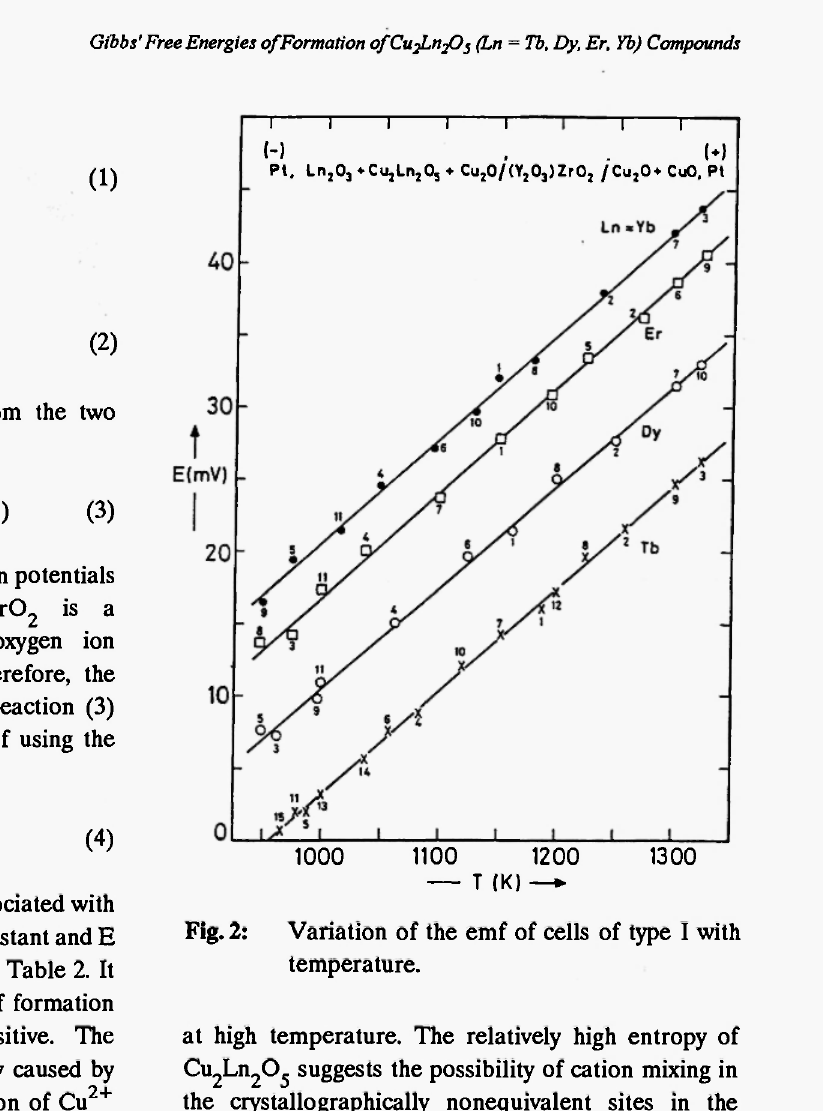
Variation of the emf of cells of type I with